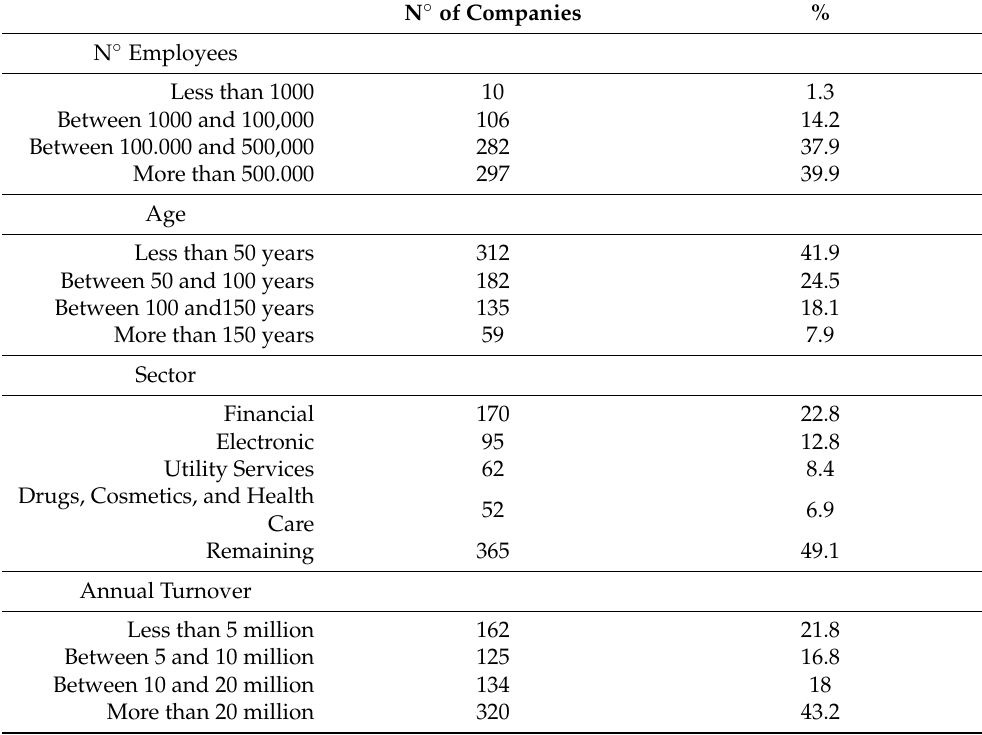
Table 2. Sample characteristics in